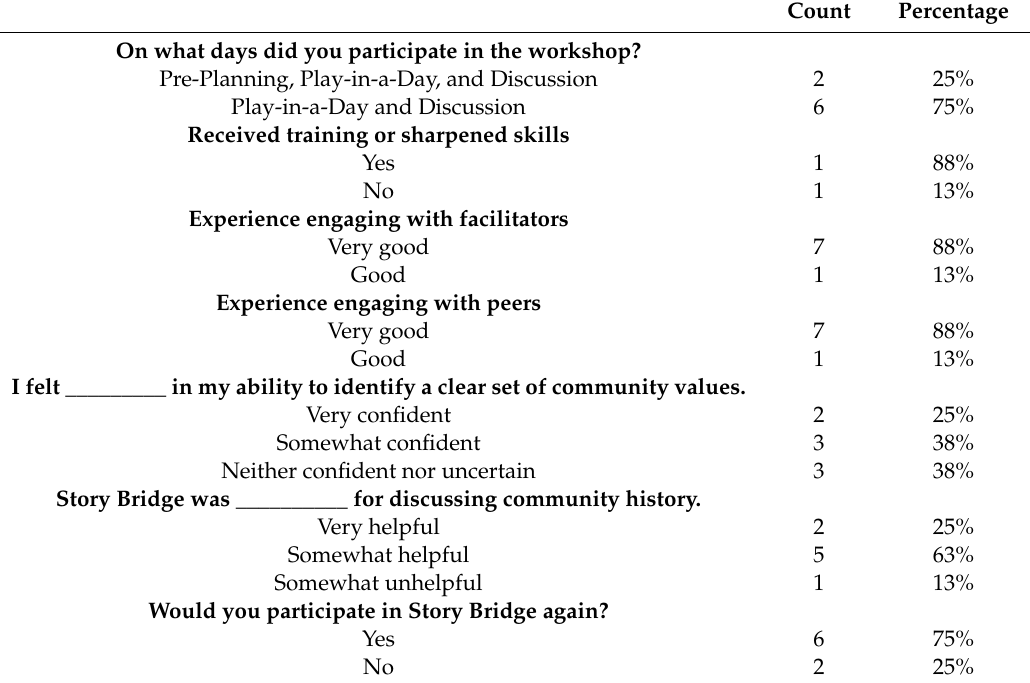
Table 3. Story Bridge program participant survey